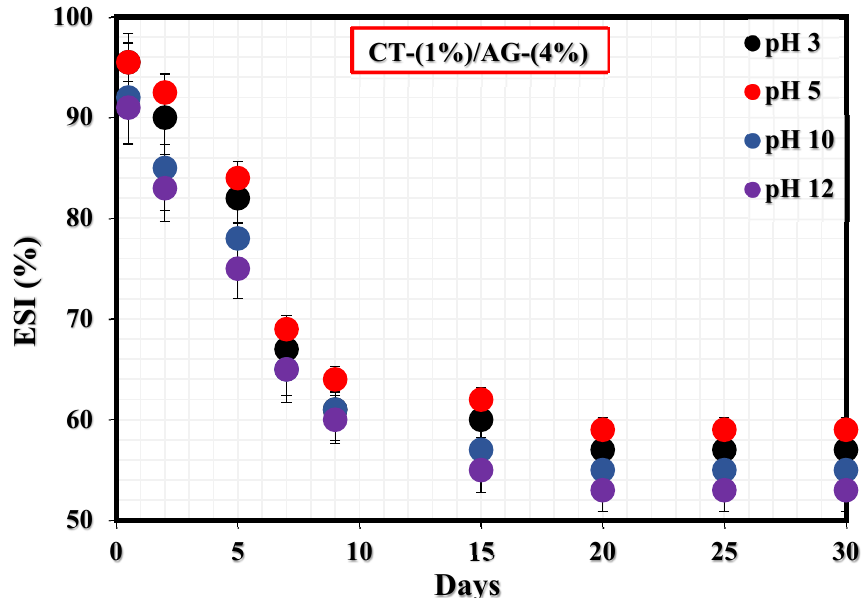
Figure 2. Stability tests of CT/AG Pickering emulsions under different pH levels.